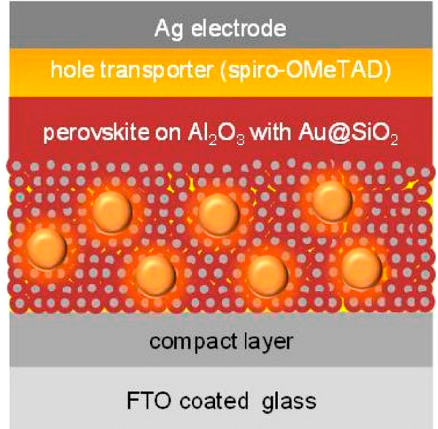
Figure 7. Au@SiO 2 -incorporated perovskite solar cell. Reproduced with permission [145]. Copyright 2013, American Chemical Society.